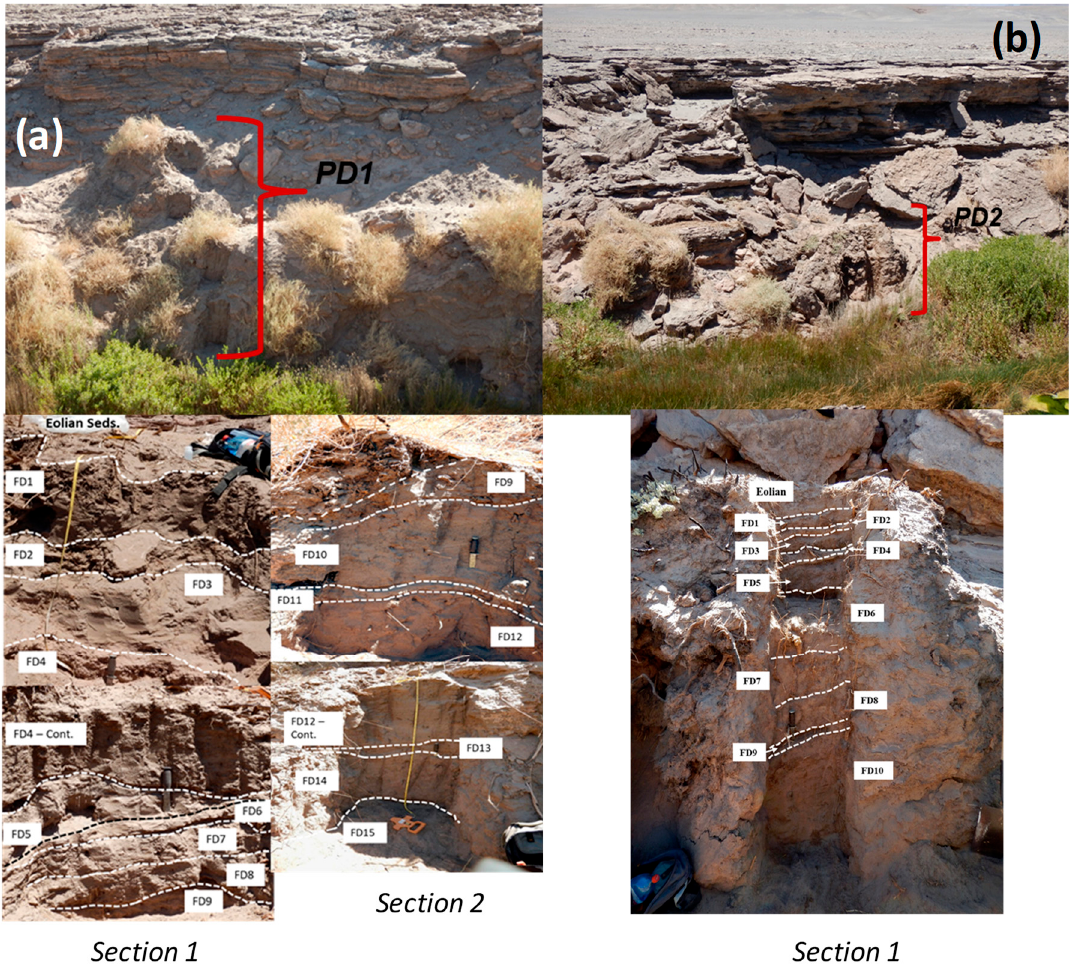
Figure 3. ( a ) Paleoflood deposits at PD1 characterized and sampled upstream of a bedrock constriction (choke point); 15 flood deposits were identified at PD1; ( b ) paleoflood deposits characterized and sampled at PD2, located downstream of the bedrock constriction. A total of 10 deposits were defined at PD2.